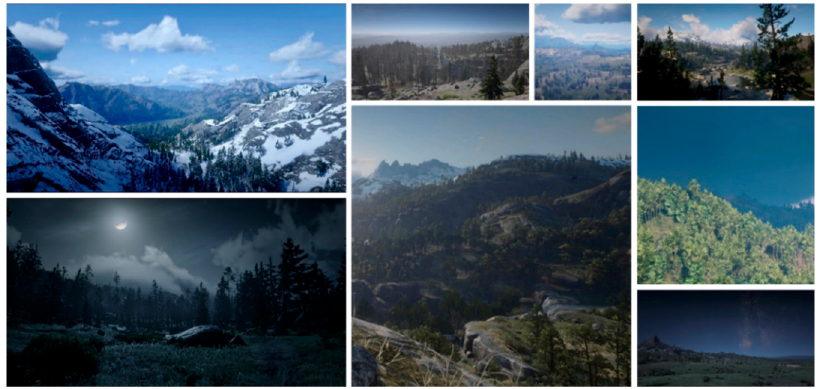
Figure 2. Sample images of virtual wildland background.